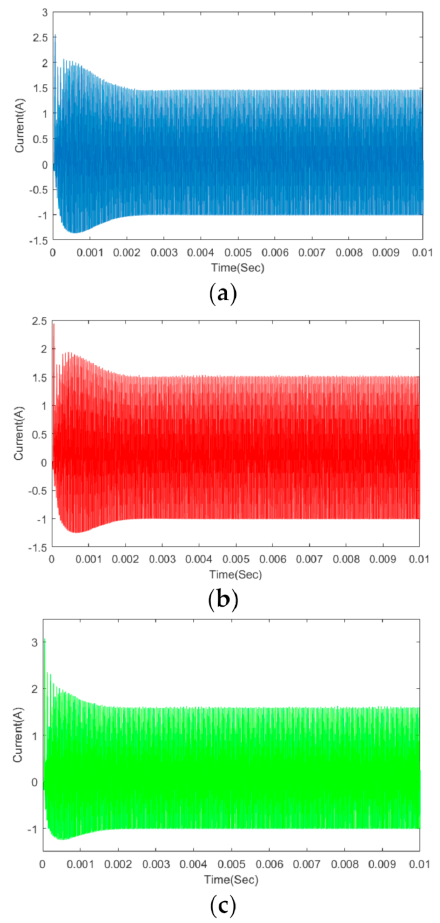
Figure 21. Steady state output current of the buck converter ( a ) first channel ( b ) second channel ( c ) third